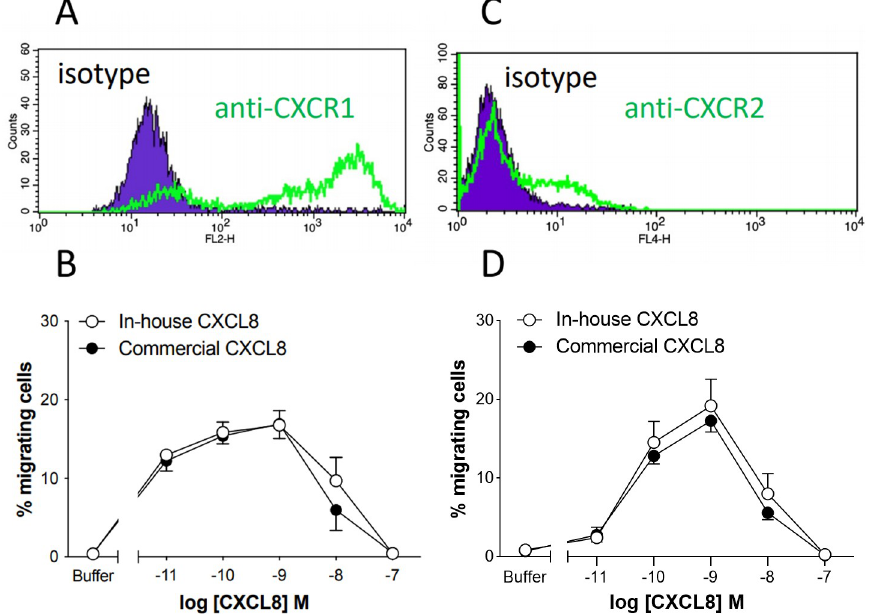
Fig 2. In-house produced CXCL8 is bioactive as deduced by chemotaxis assays. (A and C) Flow cytometry staining showing the cell surface expression of CXCR1 and CXCR2 on transfected L1.2 cells. Data are representative of three independent transfections. (B and D) The relative chemotactic activities of commercially available and in-house generated CXCL8 on CXCR1 and CXCR2 transfectants. Mean percentage migration is shown together with SEM (n =